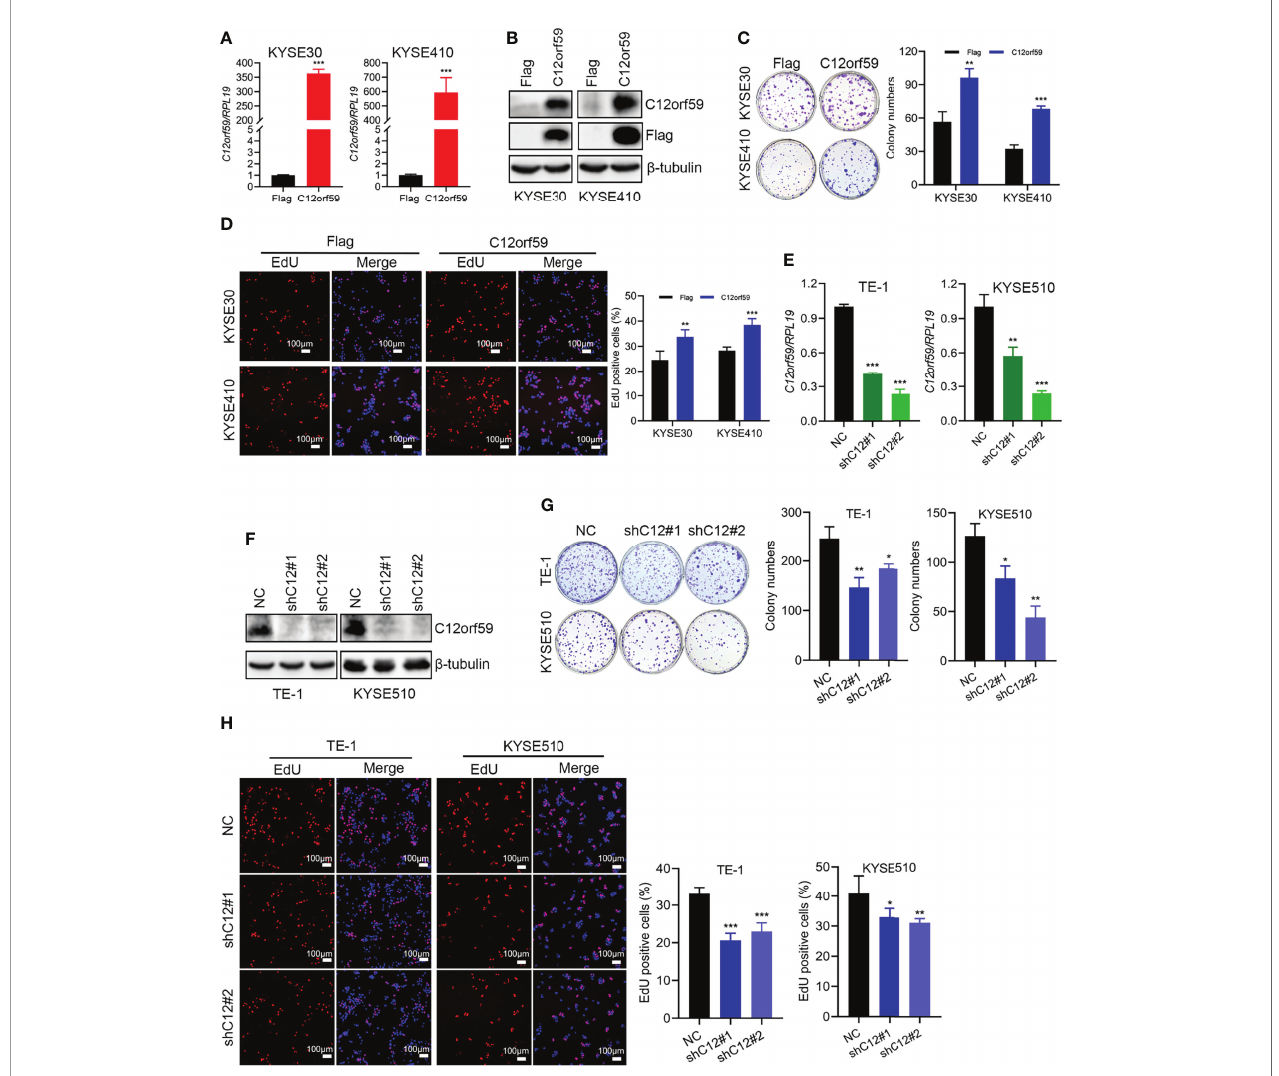
FIGURE 2 | C12orf59 increases the colony formation and proliferation of ESCC cells. (A, B) Real-time PCR and western blotting were performed to measure the C12orf59 mRNA and protein levels in KYSE30 and KYSE410 cells with infection of control or C12orf59-expressing lentivirus. (C) The capacities of colony formation were evaluated in KYSE30 and KYSE410 cells with infection of control or C12orf59-expressing lentivirus. Colony numbers were counted and quantitative analysis of colony formation was shown. (D) EdU incorporation assay was used to measure the cell proliferation of KYSE30 and KYSE410 cells. The relative proliferation rate was quanti fi ed by calculating the percentage of EdU-positive cells. Scale bar, 100 m m. (E, F) C12orf59 mRNA and protein levels were measured in TE-1 and KYSE510 cells with infection of control or C12orf59-shRNA-expressing lentivirus by real-time PCR and western blotting. (G) The capacities of colony formation were evaluated in TE-1 and KYSE510 cells with infection of control or C12orf59-shRNA-expressing lentivirus. Colony numbers were counted and quantitative analysis of colony formation was shown. (H) EdU incorporation assay was used to measure the cell proliferation of TE-1 and KYSE510 cells. The relative proliferation rate was quanti fi ed by calculating the percentage of EdU-positive cells. Scale bar, 100 m m. RPL19 was used as the internal control for real-time PCR. b -tubulin was used as the loading control for western blotting. Data were presented as mean values with standard deviations, * p < 0.05; ** p < 0.01; *** p <